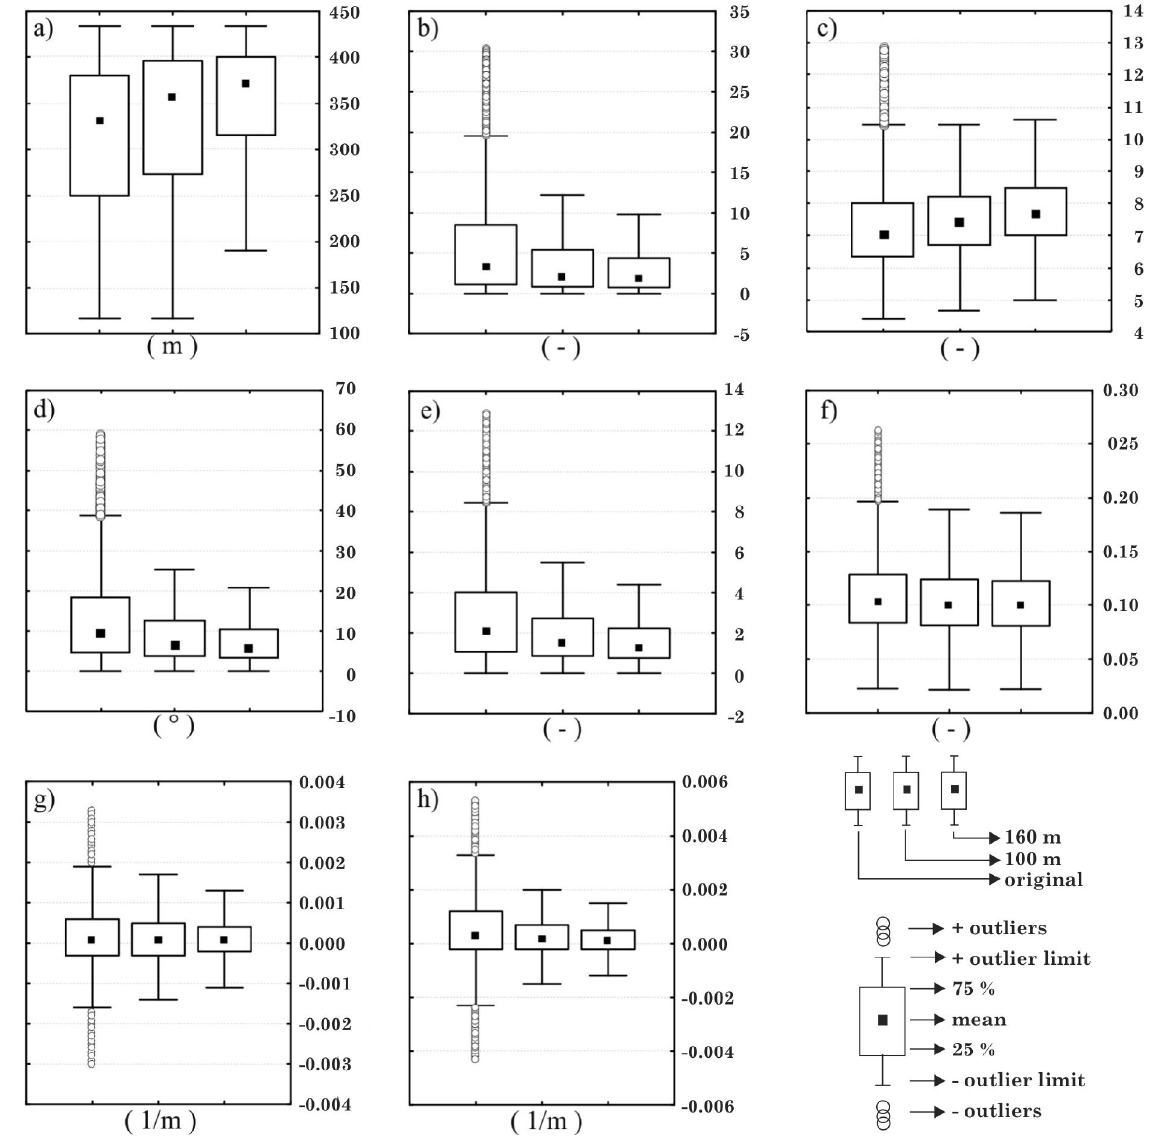
Figure 2. Boxplot of the predictive covariates created from the data sampled for the Lithic Leptosol class in the three situations of polygon positions. a) elevation (m), b) sediment transport capacity, c) topographic wetness index, d) slope (°), e) terrain roughness index, f) standard deviation of the NDVI, g) plane curvature (1/m) and h) profile curvature (1/m). Units of each covariate in parentheses. The outlier limit was calculated from the height of the central box of the boxplot multiplied by 1.5. Outliers were defined as the values beyond the outlier